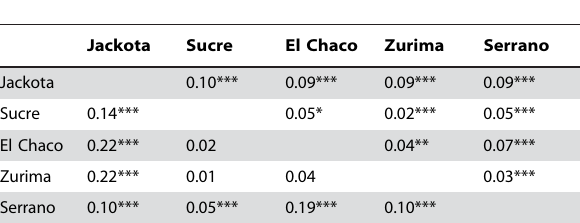
Table 4. Pairwise estimates of multilocus R ST (below diagonal) and F ST (above diagonal) between samples of